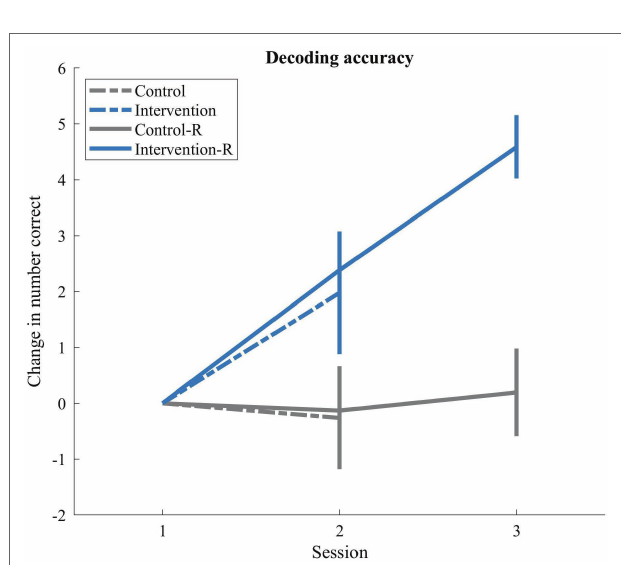
FIGURE 7 | Comparing rate of change for in-person versus remote study. Line plots depict mean change at the group-level for the intervention groups (blue) and control groups (gray) on a composite of real-word and pseudo- word decoding performance. Lines are shown for both a previous, in-person implementation (dotted) and the remote (solid) version delivered in response to the pandemic. Error bars represent +/ − 1